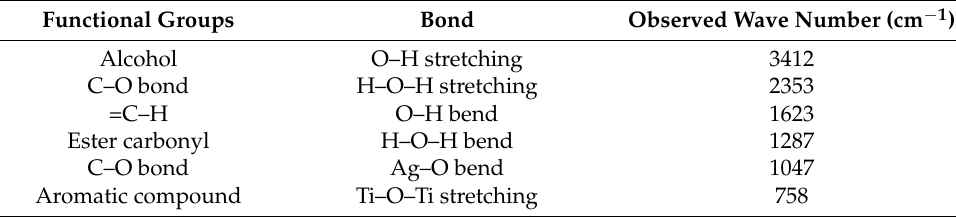
Figure 2. FTIR analysis of pure and composite nanoparticles. Table 1. Functional groups of nanoparticles extracted from FTIR spectra.